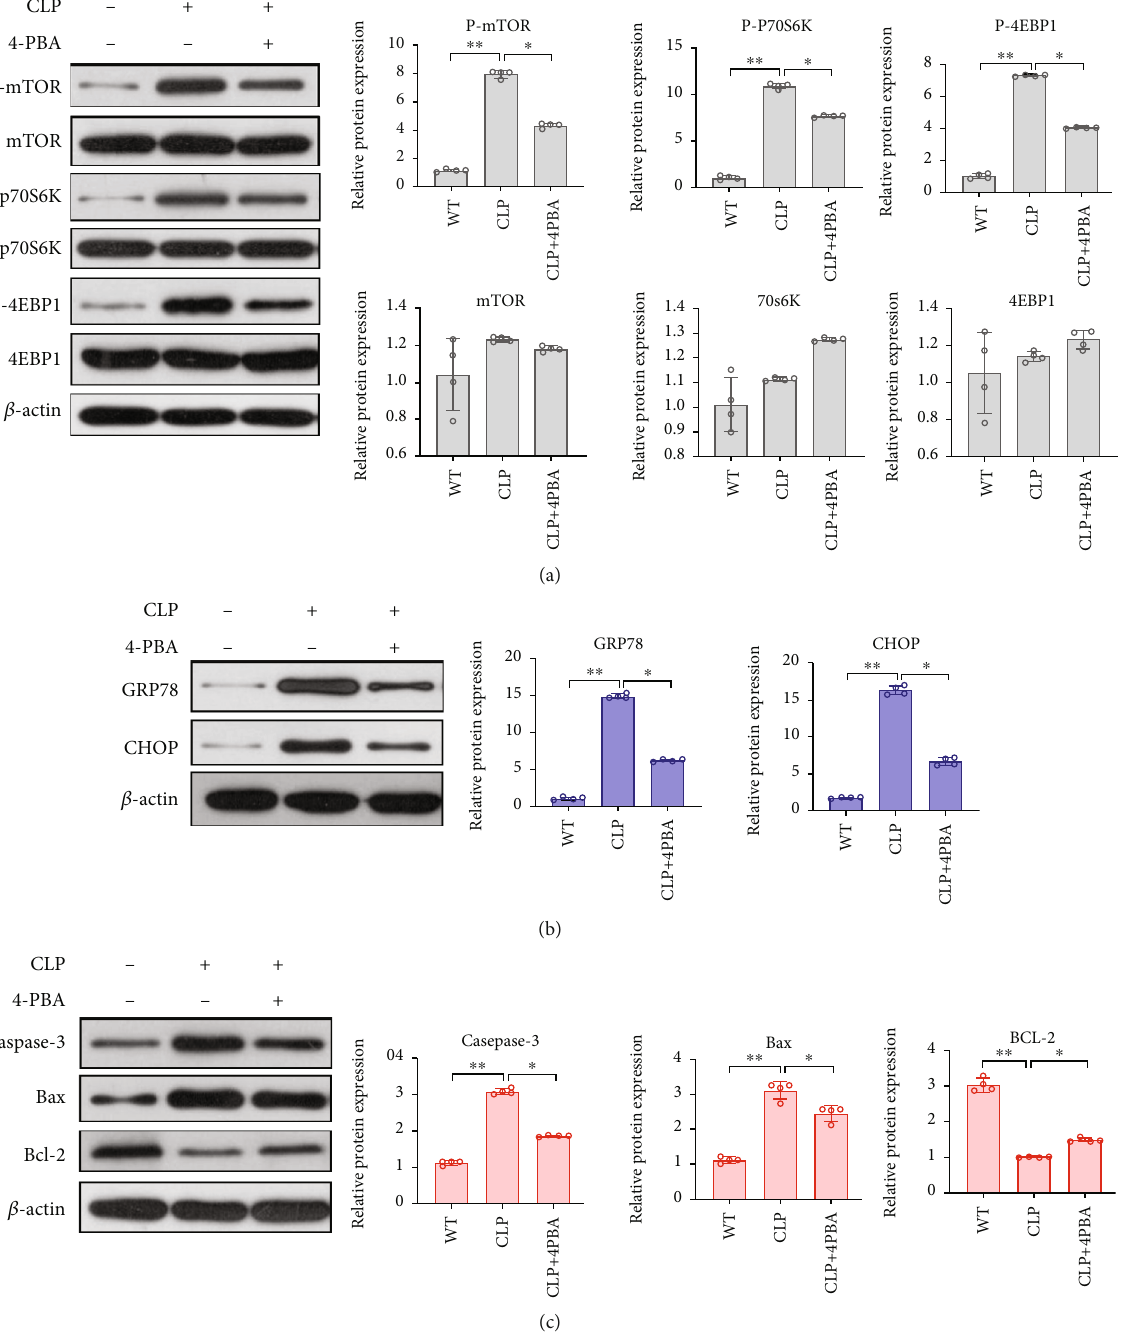
Figure 3: Expression levels of mTOR pathway proteins, ERS-associated proteins, and apoptosis-associated proteins in WT, CLP, and CLP +4-PBA mouse groups. After purifying the CD4 + T cells from mouse spleen lymphocytes, whole cell lysates were assessed for the protein expression of (a) patterns of mTOR pathway proteins, including mTOR, P-mTOR, downstream e ff ectors p70s6k, p-p70s6k, 4EBP, and P-4EBP; (b) ERS-associated proteins, including GRP78 and CHOP; (c) apoptosis-associated proteins, including caspase-3, Bax, and Bcl- 2. The protein expression was detected by immunoblotting. Data are mean ± SD . n = 4 biologically independent experiments (one-way ANOVA Tukey ’ s post hoc test). ∗ P < 0 : 05 , ∗∗ P < 0 : 01 , and ∗∗∗ P < 0 : 001